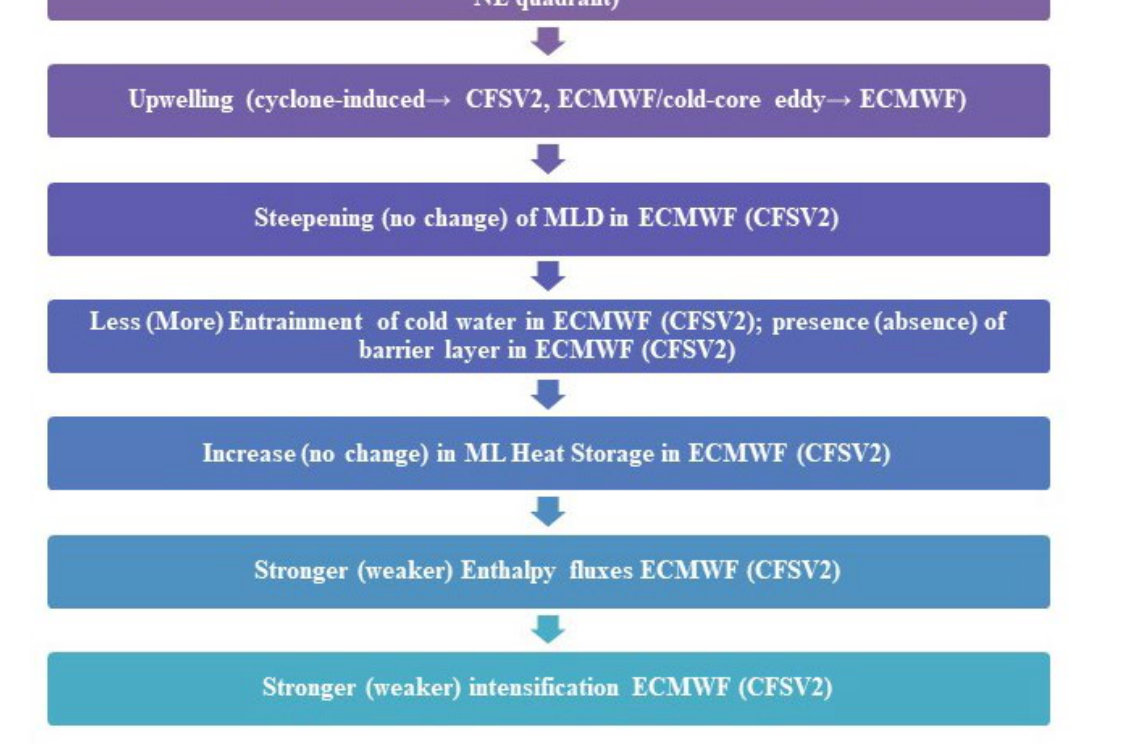
Figure 13. Schematic of the ocean processes influencing the intensification of TC Phailin in the simulations.